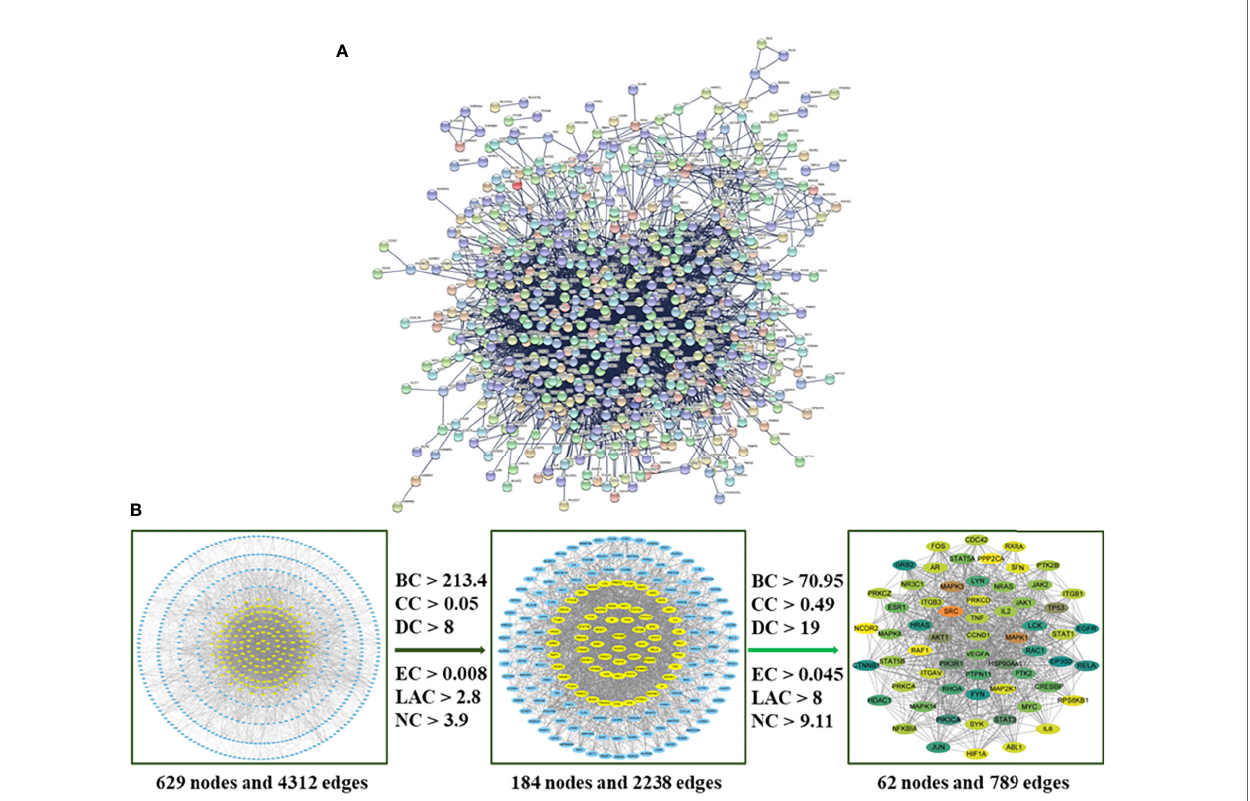
FIGURE 4 | (A) The PPI network of 756 intersection targets from the HMMCR for treatment of NSCLC. (B) The process of hub network topological screening. The BC, CC, DC, EC, LAC, and NC values of each target are calculated; nodes higher than twice the median value are further selected as hub targets.